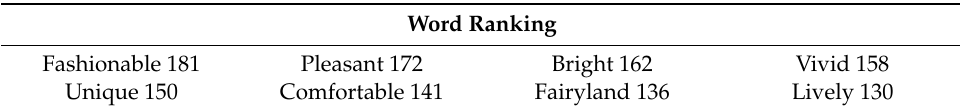
Table 7. Vocabulary